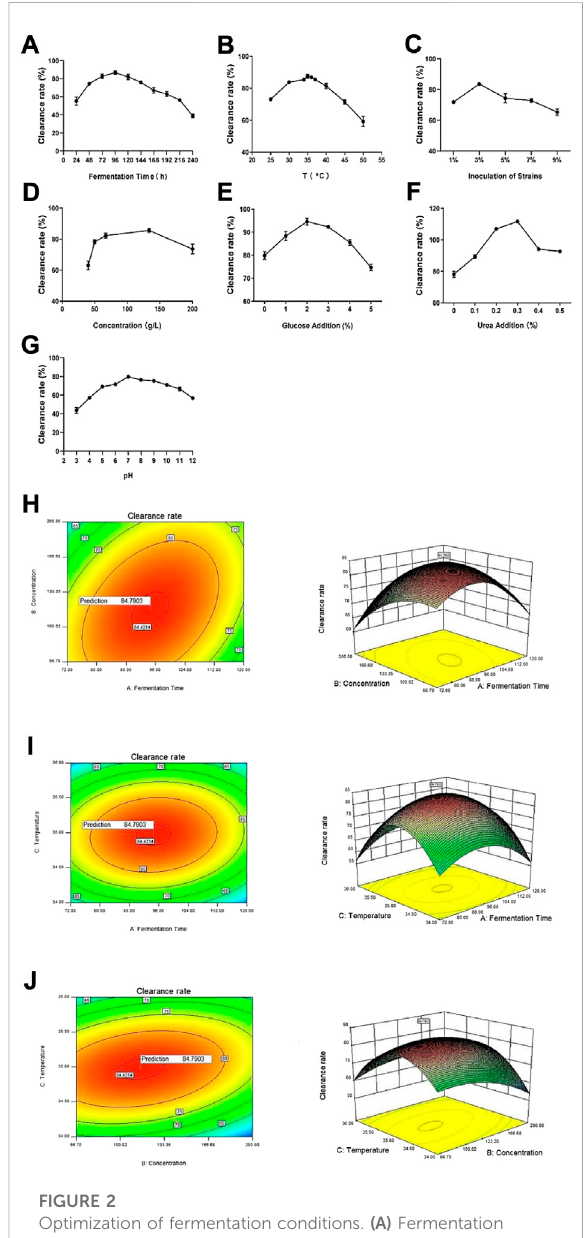
Optimization of fermentation conditions. (A) Fermentation time, (B) temperature (C) strain inoculation amount, (D) concentration (E) glucose addition, (F) urea addition (G) pH. And response surface and contour plots of the interactive effects of (H) fermentation time and concentration (I) fermentation time and temperature and (J) temperature and